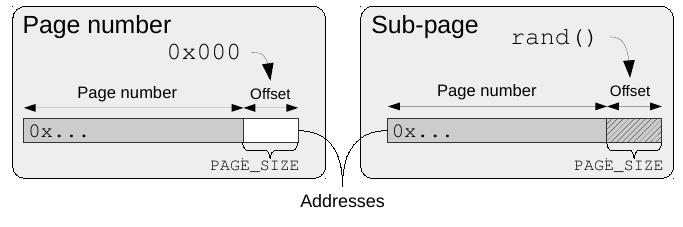
Figure 5. Sub-page